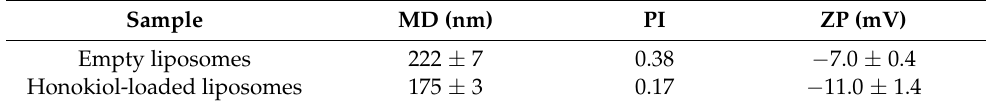
Table 3. The mean diameter (MD), polydispersity index (PI), and zeta potential (ZP) of empty and